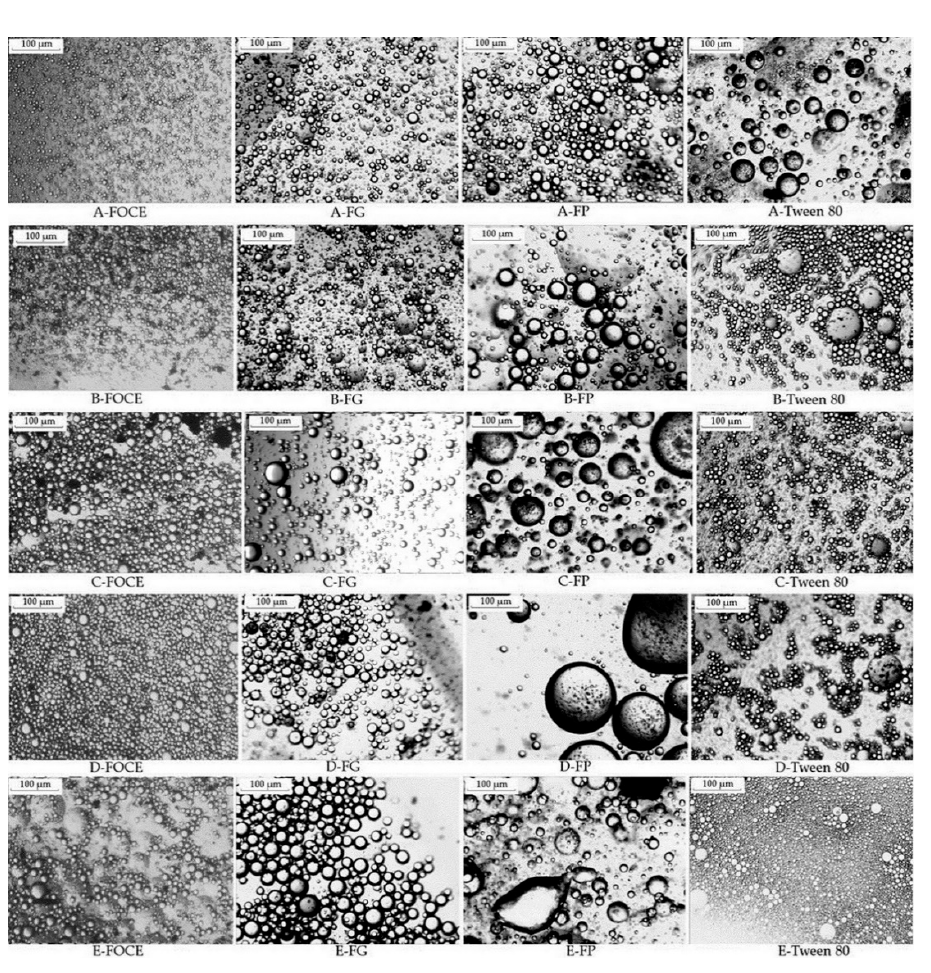
Figure 4. Optical microscopic images of emulsions prepared with various FO and FOCE contents, FP, FG and Tween 80. * FOCE—flaxseed oil cake extract; FG—flaxseed gum solution; FP—flaxseed protein solution; ( A – E ) emulsions prepared with 10%, 20%, 30%, 40% and 50% oil phase, respectively. Table 2. D 4,3 and SPAN values of emulsions prepared with various content of oil.